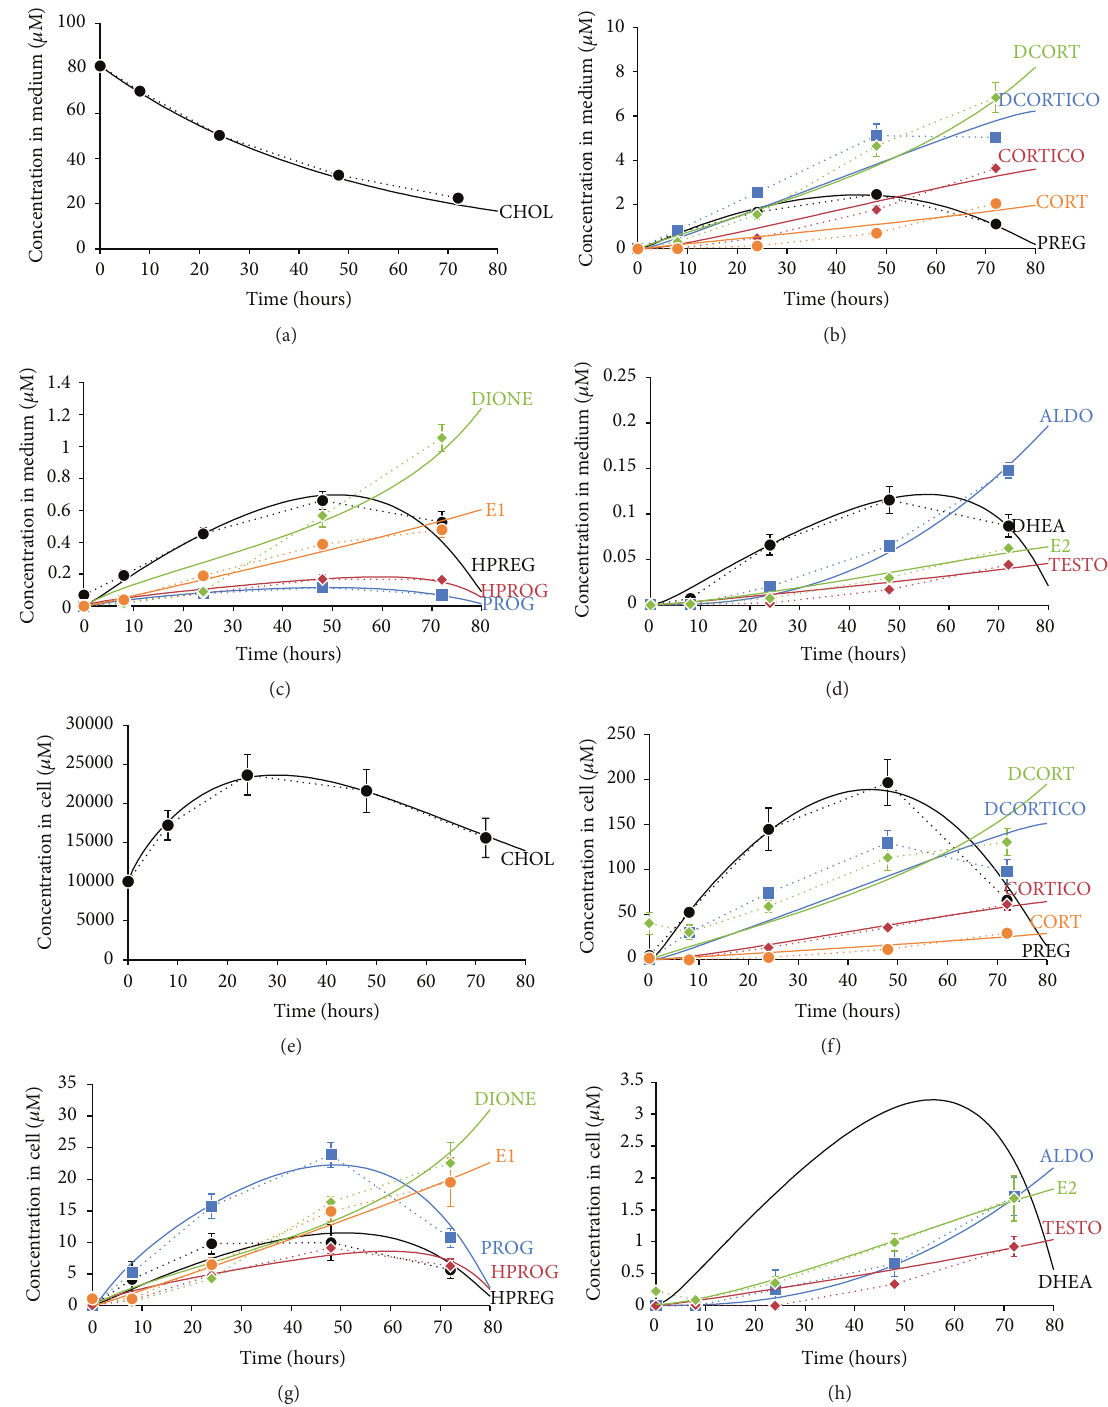
Figure 4: Comparison of time-course profiles of cholesterol and adrenal steroids produced by NCI-H295R cells between experimentally measured and simulated data. To intuitively confirm reconstruction of the measured experimental data in the developed simulation model of NCI-H295R cells, dynamics of cholesterol and adrenal steroids produced by NCI-H295R cells were plotted to overlay experimental data with the simulated results. Graphs show the dynamics of medium concentrations of cholesterol (a) and adrenal steroids ((b)–(d)) and intracellular concentrations of cholesterol (e) and adrenal steroids ((f)–(h)). Steroid hormones were categorized into three groups by concentration levels. Major steroids were PREG: pregnenolone, DCORTICO: 11-deoxycorticosterone, DCORT: 11-deoxycortisol, CORTICO: corticosterone, and CORT: cortisol ((b) and (f)). Moderate steroids were HPREG: 17 𝛼 -hydroxypregnenolone, PROG: progesterone, HPROG: 17 𝛼 -hydroxyprogesterone, DIONE: androstenedione, and E1: estrone ((c) and (g)). Minor steroids were DHEA: dehydroepiandrosterone, ALDO: aldosterone, TESTO: testosterone, and E2: 17 𝛽 -estradiol ((d) and (h)). Experimental data are shown as symbols with dotted lines. All data represent the mean ± SD ( 𝑁 = 4 ). Simulation data are shown as solid